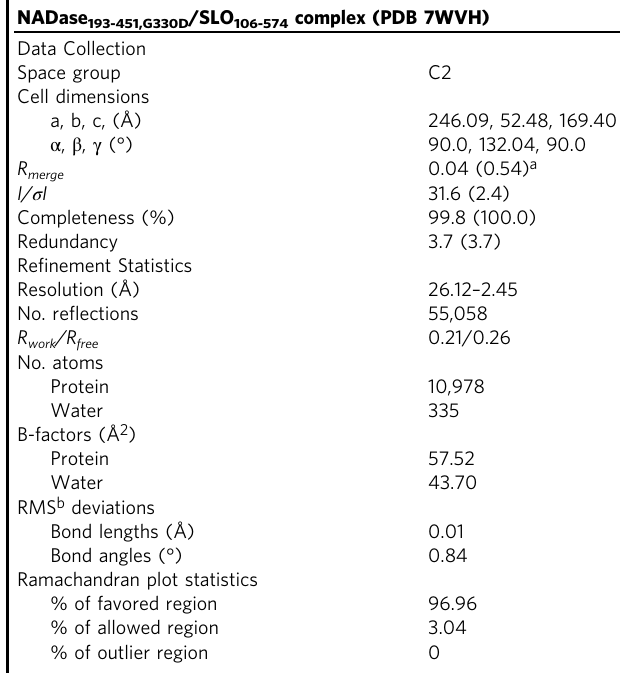
Table 1 Crystallographic data and re fi nement statistics.